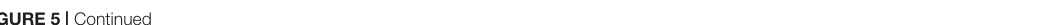
FIGURE 5 | Continued EIF, Eukaryotic translation initiation factor-like; F3 (cid:48) H, Flavonoid 3 (cid:48) -hydroxylase; FKBP62, Peptidyl-prolyl cis-trans isomerase FKBP62; FTSHI, Probable inactive ATP-dependent zinc metalloprotease FTSHI; GASA14, Gibberellin-regulated protein 14; GDPDL3, Glycerophosphodiester phosphodiesterase 3; hnRNP Q, Heterogeneous nuclear ribonucleoprotein; IFRL, isoflavone reductase-like protein; JIP23, 23 kDa jasmonate-induced protein; LRPK, Leucine-rich repeat receptor-like serine/threonine-protein kinase; NAP1;4, Nucleosome assembly protein 1;4; Nhp2-like protein, ACA ribonucleoprotein complex subunit 2-like protein; NRT, Nitrate transporter; OCT2, Organic cation/carnitine transporter 2; PAP1, Polyadenylate-binding protein-interacting protein 1; PHT1:3, inorganic phosphate transporter 1-3; PIP5K, Phosphatidylinositol-4-phosphate 5-kinase; PLC4, Phosphoinositide phospholipase C 4; PNO1, Pre-rRNA-processing protein; Prp3, U4/U6 small nuclear ribonucleoprotein; Rpn3, 26S proteasome non-ATPase regulatory subunit 3; SBT1.2, Subtilisin-like protease; SULTR, Sulfate transporter; SUMO1, Small ubiquitin-related modifier